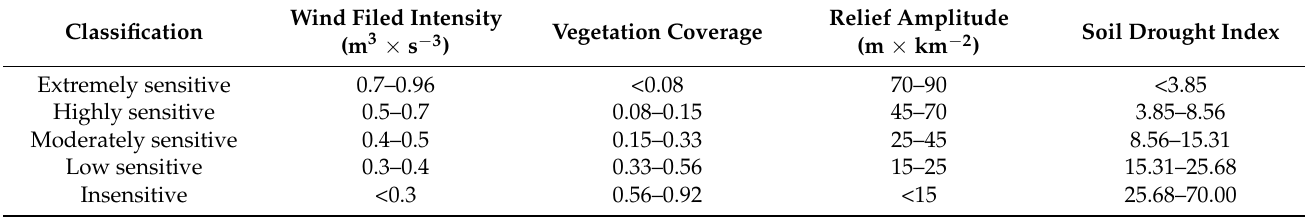
Table 1. Criteria for the sensitivity scale.